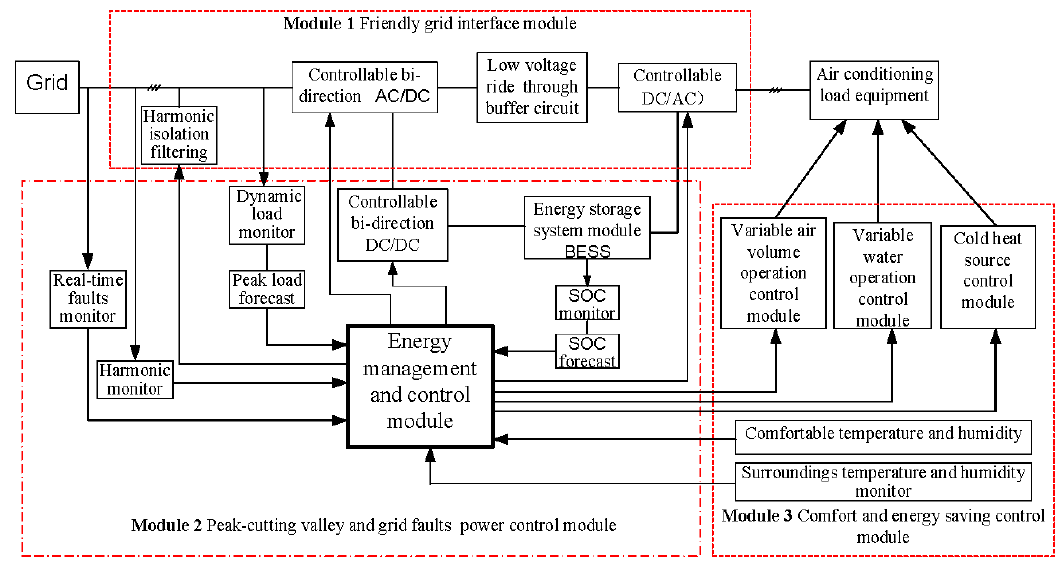
Figure 1. The module structure of active demand management.